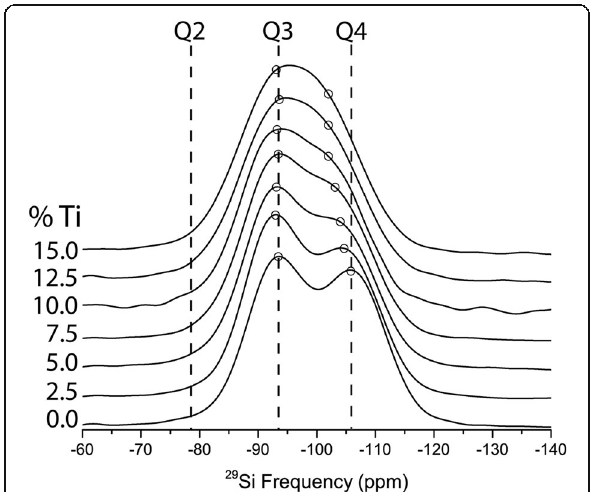
Fig. 3 Stacked 29 Si NMR data for NS4 glass at various Ti concentrations, normalized by integrated intensity. The two predominant peaks are the Q 3 and Q 4 peaks at − 93 and − 106 ppm, respectively. At 0% TiO 2 , the two peaks account for nearly equal areas under the curve, as is expected for NS4 glasses with 50% Q 3 Si and 50% Q 4 Si. There is a shift in peak position of the Q 4 to higher frequency with addition of Ti to the NS4 glass, whereas the Q 3 peak is negligibly affected by the addition of Ti. The shift in Q 4 to higher frequency is likely the result of Ti nearest neighbor effects on the Q 4 Si. Open circles are fitted peak centers